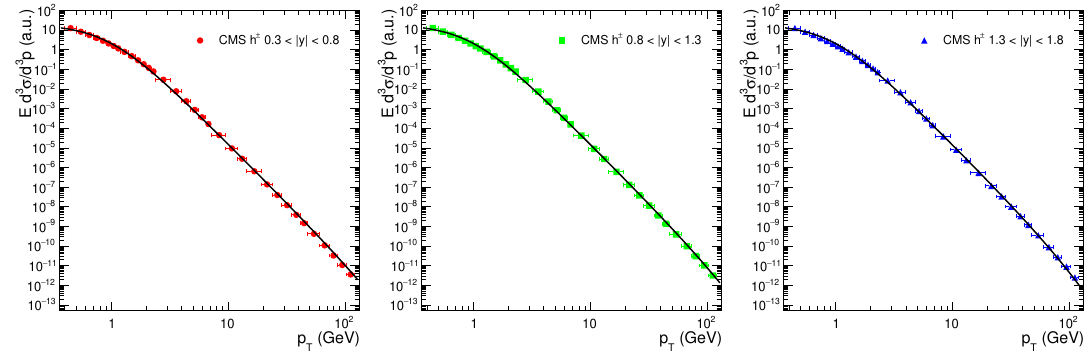
Figure 10 . Charged hadron spectra measured by CMS in pPb collisions at p s = 5 : 02 TeV in the rapidity ranges 0 : 3 < to the parametrization